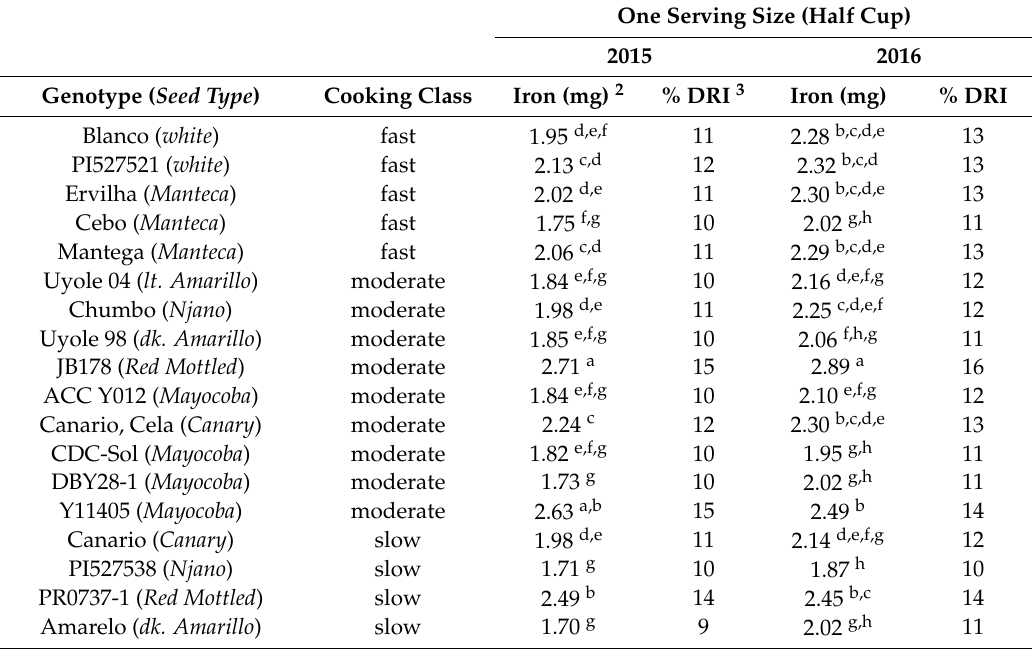
Table 4. Cooked Seed Iron Density of Pre-Soaked Genotypes in the Yellow Bean Panel Organized by Cooking Class 1